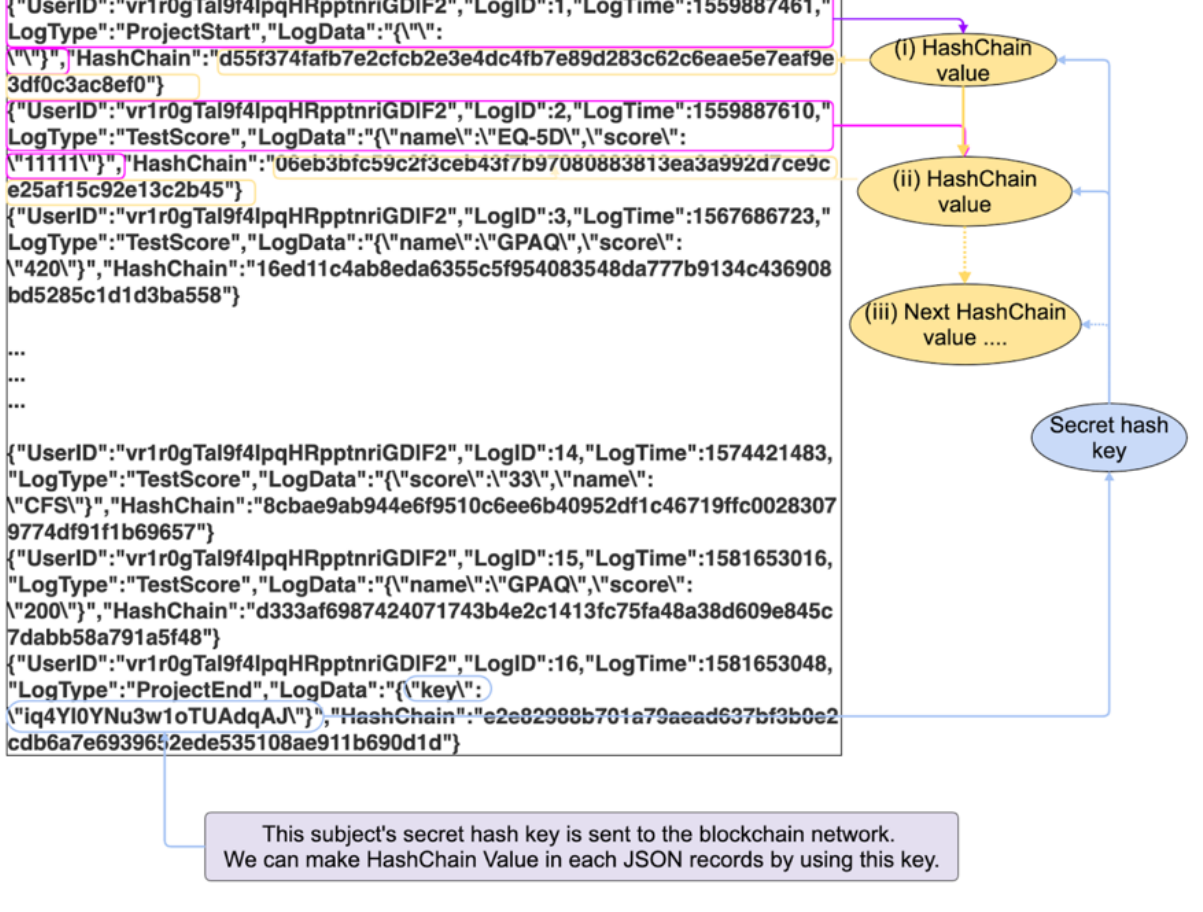
Figure 5. Data verification and validation using client hashchain. The first hash value is made from the first data and secret hash key. Subsequent hash values are made from clinical data, the previous hash key, and secret hash